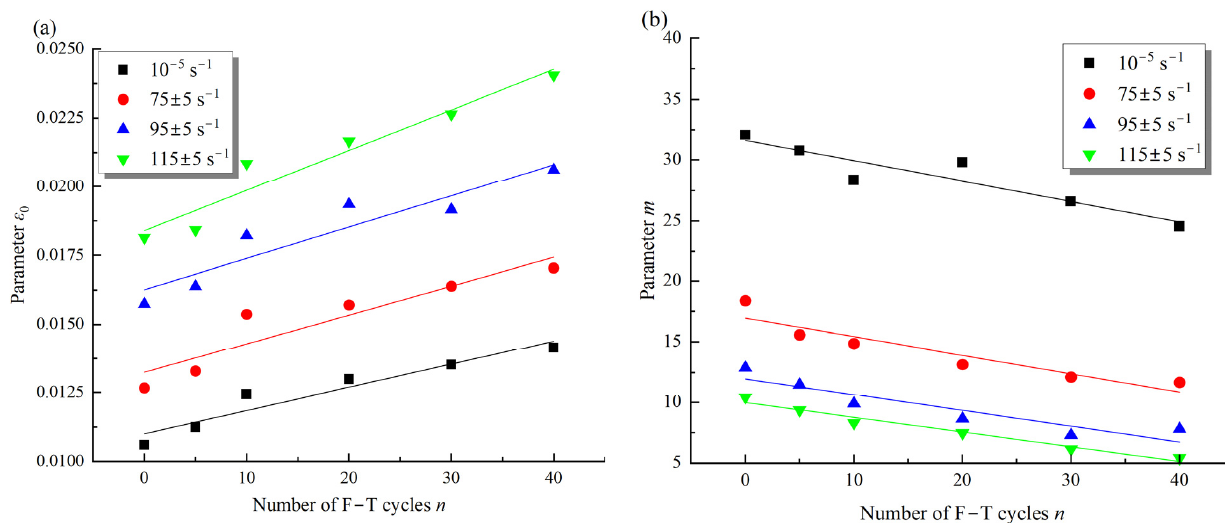
Figure 19. Variation of the parameters ε 0 ( a ) and m ( b ) with the strain rate and cyclic F–T action. Based on the Equation (15) and the parameters ε 0 , m , and α , the damage evolution of the samples under dynamic loading and F–T action was investigated. The D m with the strain rate of the samples after 20 F–T cycles is shown in Figure 20a, and the D m with the different F–T cycles at the same loading is displayed in Figure 20b. The evolution curve of D m exhibits distinct phase characteristics. In the initial phase, the D m of the samples increases slowly; as the strain increases, the D m shows a lower convex increase; when the loading continues to increase, the damage curve gradually changes to an upper convex increase; in the final phase of the stress, the rock sample fractures, and the damage curve tends to